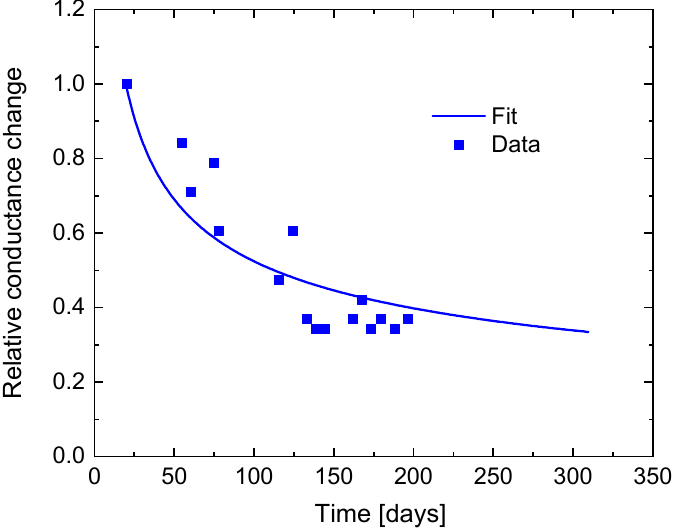
Figure 7. Decrease in baseline conductivity upon slow relaxation from quenched-in non-equilibrium states towards equilibrium states corresponding to the sensor operation temperature of 673 K applied in the experiments described in Section 2: Full line: calculated from Equation (14) assuming bulk conductivity limitation; data points: Brescia long-term sensing test (Section 2).